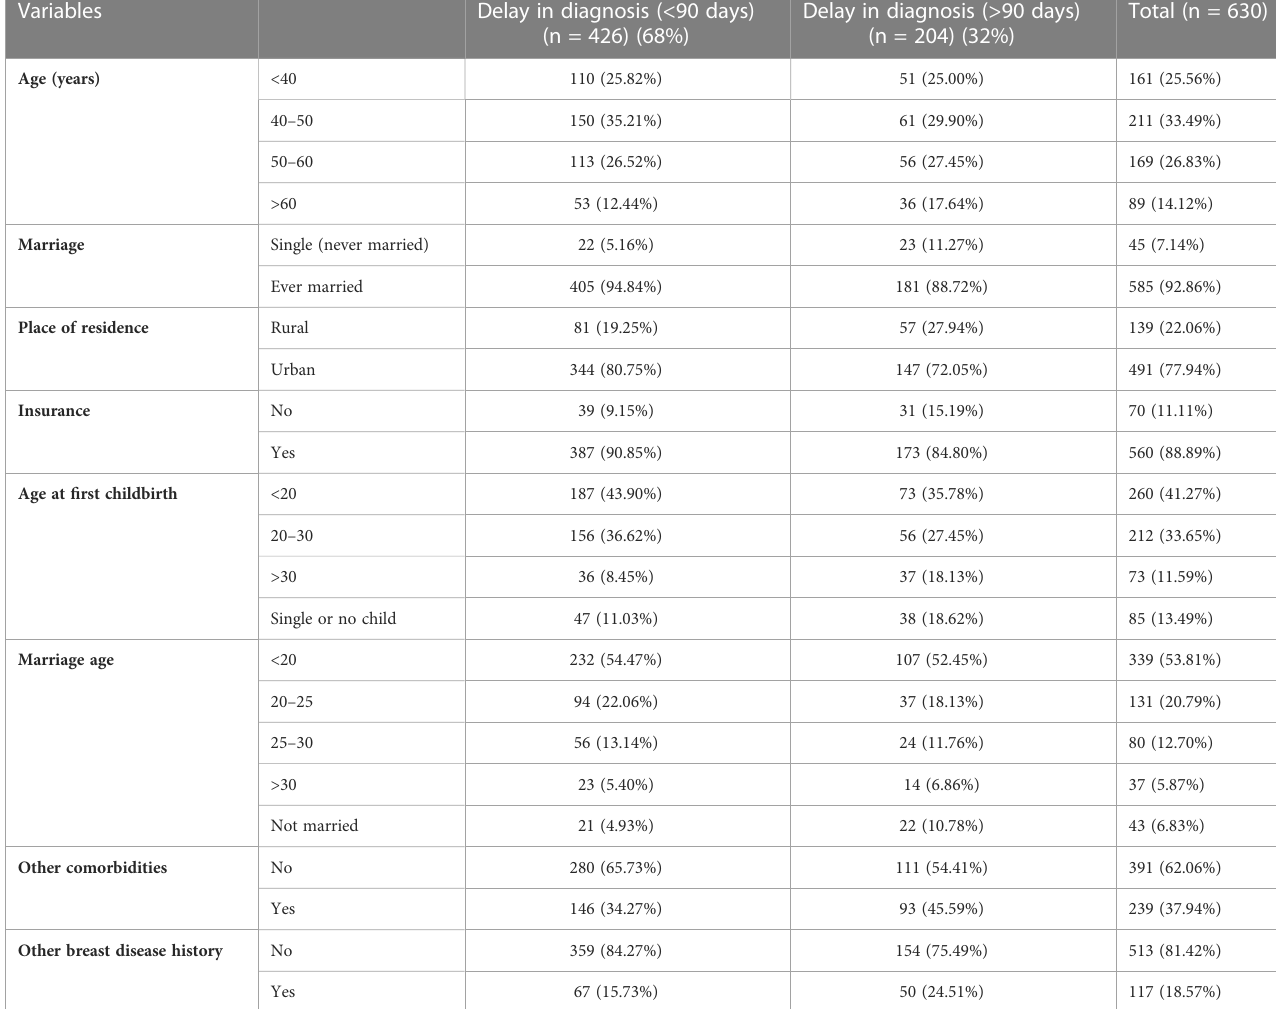
TABLE 5 Statistics of BC patients based on model